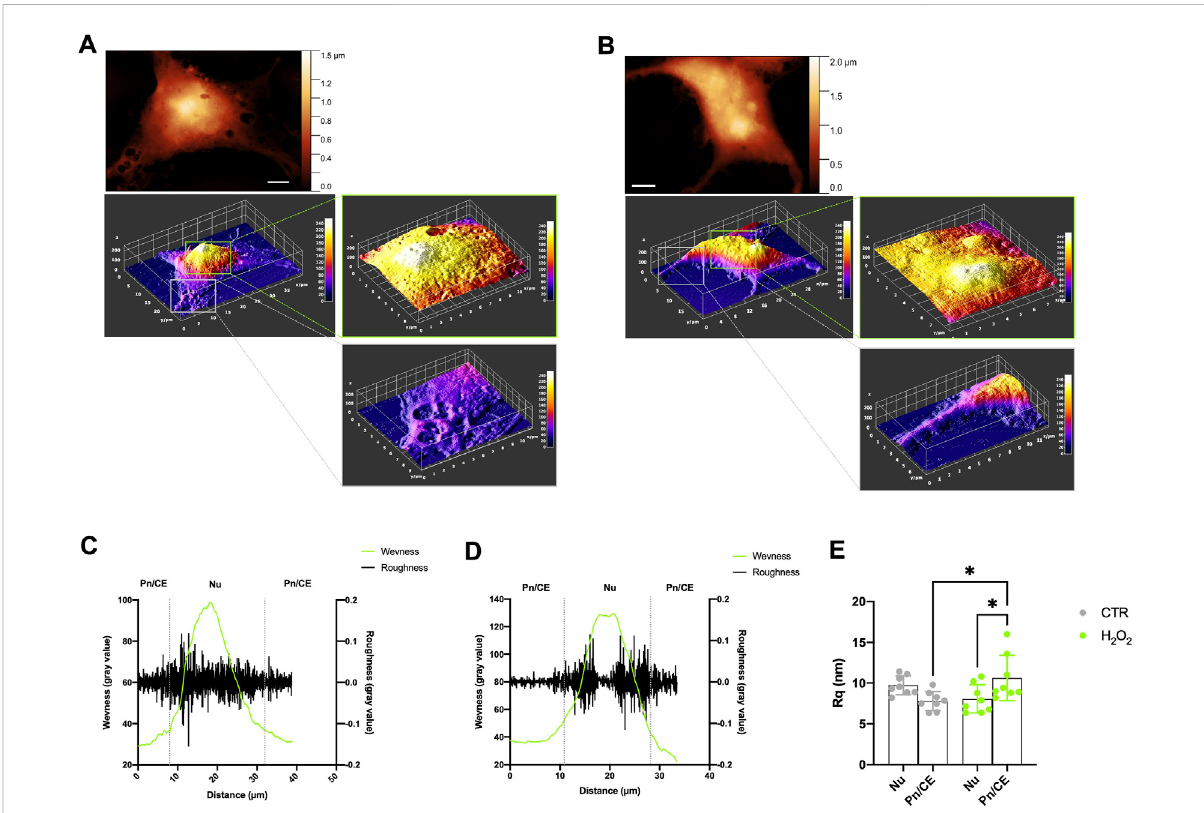
FIGURE 4 Roughnessandwaviness analysis performed ontheAFM images. (A) and (B) example oftheprocedure to select the6× 6micronswide regions onnuclearandperinuclearareasononecontrolcell(Panel A)andoneH2O2treatedcell (B) ,scalebars5microns. (C) and (D) exampleofcalculation of roughness (black line) and waviness (green line) along a line onto an entire control (C) and H2O2 treated (D) cell, the grey vertical dotted lines separate the nuclear (Nu) and perinuclear (Pn/CE) regions. (E) roughness values obtained from all the images sampled, each dot is representativeofaregion(NuorPn/CE)for eachcell,theresultsobtained onthecontrol cellsareshowningreydotswhile theonesobtained onthe H2O2 treated cells are shown in green dots. The average values of roughness obtained for the control cells are 9.8 ± 1.2 nm and 7.8 ± 1.2 nm in the nuclearandperinuclearregions,respectively.WhilefortheH2O2treatedones,theobtainedvaluesare8.1±1.7 nmand10.6±2.8 nmforthenuclear and perinuclear regions, respectively. The mean roughness values were statistically different between nuclear and perinuclear regions ( p < 0.05) in the H2O2 treated samples and in the perinuclear region between control and H2O2 treated cells ( p <